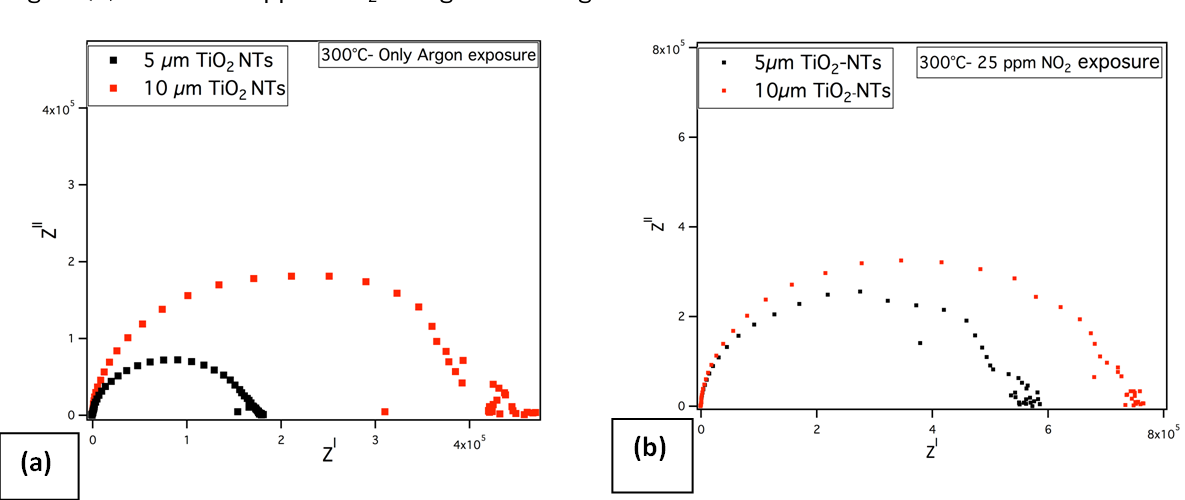
Figure 11. Equivalent circuit model of the sensor with TiO corresponding sensor parts C